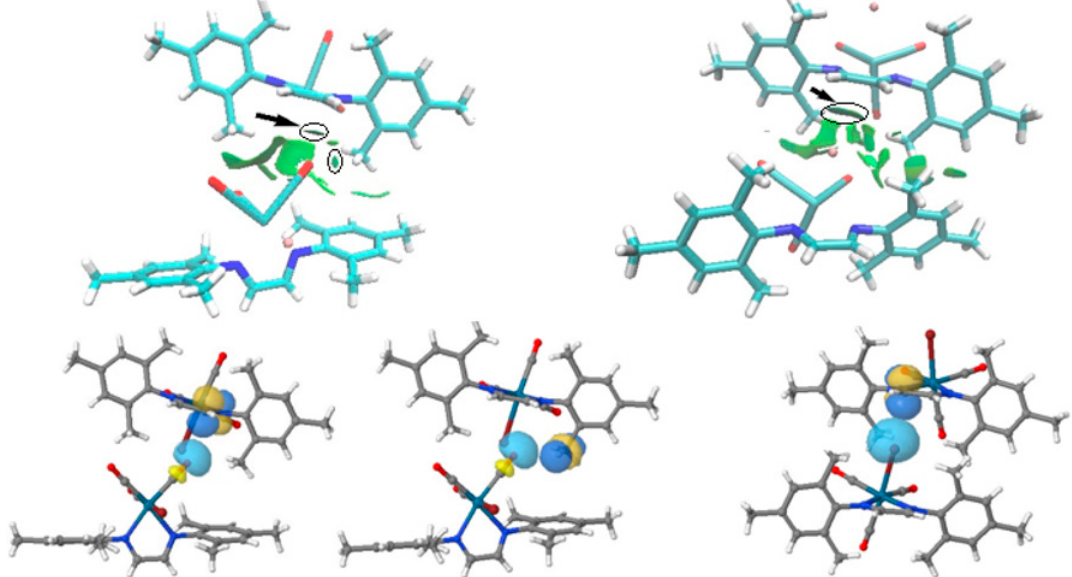
Figure 7. NCI plot of the interacting dimer in 3 and the representation of donor–acceptor interacting n(O) ... π *, n(O) ... σ *, and n(Br) ... π * orbitals from NBO calculations. The area is shown in the NCI plot with arrows.